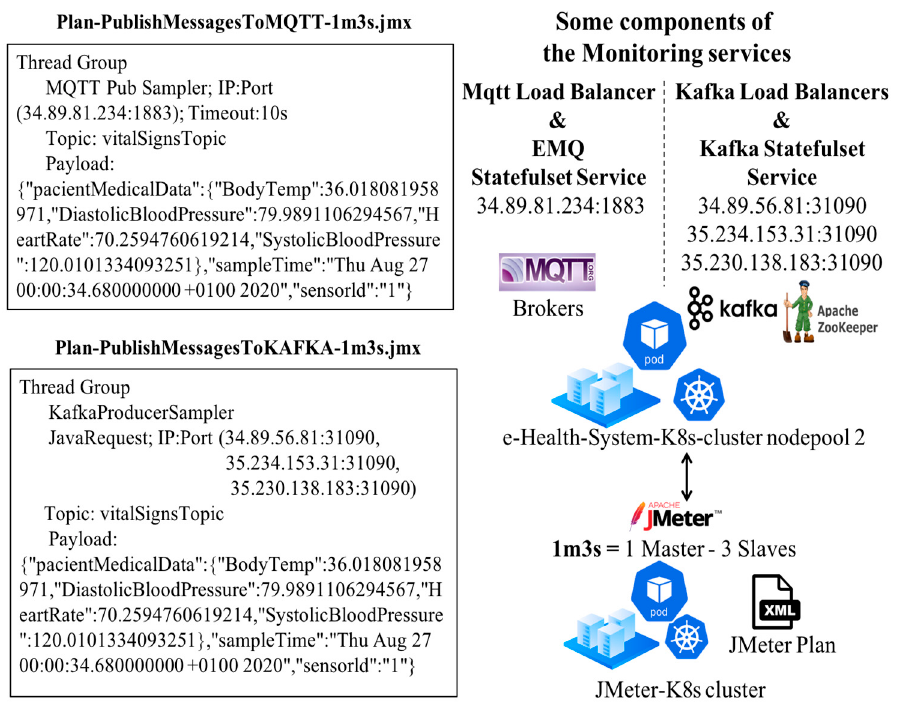
Figure 16. The simulation environment for the EMQ cluster and Kafka cluster tests.